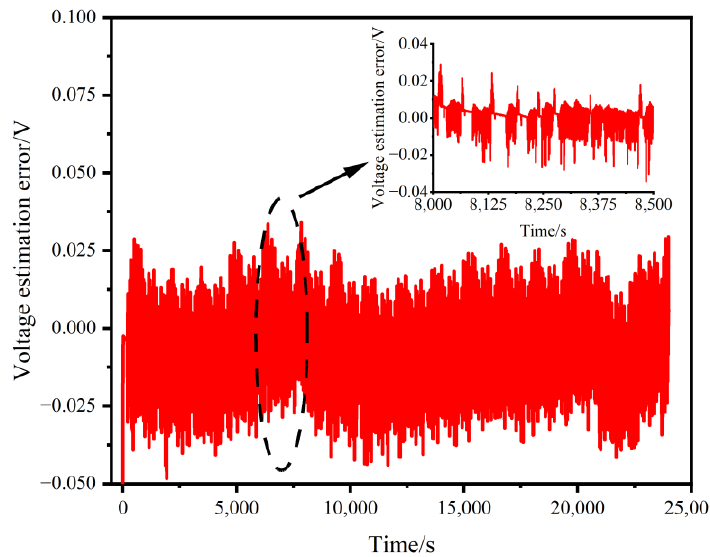
Figure 7. Battery terminal voltage error diagram.